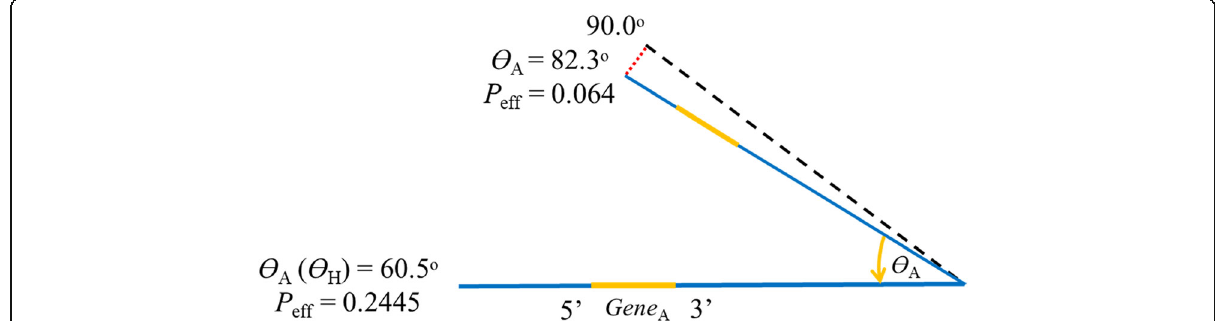
Fig. 2 Angulation of intergene base arc distance tropy in reference to the z , x -axis horizontal plane for anisotropic heterochromatin loop segment genes. Anisotropic heterochromatin strand loop micro-structural arrangement is a series of ≥ 3 intergene base distance-separated genes perceiving the asymmetric tropy viscosity effect with nano-compliance of the same, Θ A, lncRNA class gene GC01P156524 ( P eff , 0.199)-containing anisotropic form heterochromatin strand loop segment for example is arranged as GC01P156524 ( Θ A = 66 0 )- TTC24 ( Θ A = 72.4 0 )- NAXE ( Θ A = 67.0 0 )- HALPN2 ( Θ A = 67.3 0 )- BCAN ( Θ A = 60.6 0 ) in series from 5 ’ to 3 ’ on human ch 1q22 at positions +11 through +15 in reference to LMNA . As shown is a gene of an anisotropic heterochromatin segment loop positioned at Θ A = 60.49 0 ( P e ff , 0.2445) in the z , y -axis plane is transcriptionally active at Θ Θ Θ A = H , and ch 14q32.3 reverse strand (-) IGH_ immunoglobin heavy chain locus gene, MIR4537 , positioned at the upper limit of angulation A = 82.3 0 , aligns for z , x -horizontal plane transcription at a P eff = 0.064 esebssiwaagoT Q units. Legend. Θ H, zero degree horizontal axis line of unity; d A , hypotenusal distance of anisotropic gene intergene tropy bases; d A sin Θ A , distance to horizontal for anisotropic gene intergene tropy distance; d SEMA4A is a 2 M 5 initial and final SEB gene locus bases. The P for gene locus for SEMA4A is 0.135 eff esebssiwaagoT units (Table 1; Figs. 1, 2 and 3). with a Σ intergene base segment tropy of 2.95365E + 05 Q SLC25A44 is a 2 A 5 initial and final SEB gene locus intergene bases at position +1. Sequential integration ( ∫ ) with a Σ intergene base segment tropy of 3.62292E + 05 to the final esebssiwaagoT for SEMA4A is 0.449, 0.170, Q intergene bases at position +2. Sequential integration ( ∫ ) 0.173. The final uppesebssiwaa and dppesebssiwaa for SEMA4A are 7.891E + 03 and 5.8332E + 04 intergene to the final esebssiwaagoT for SLC25A44 is 0.184, Q